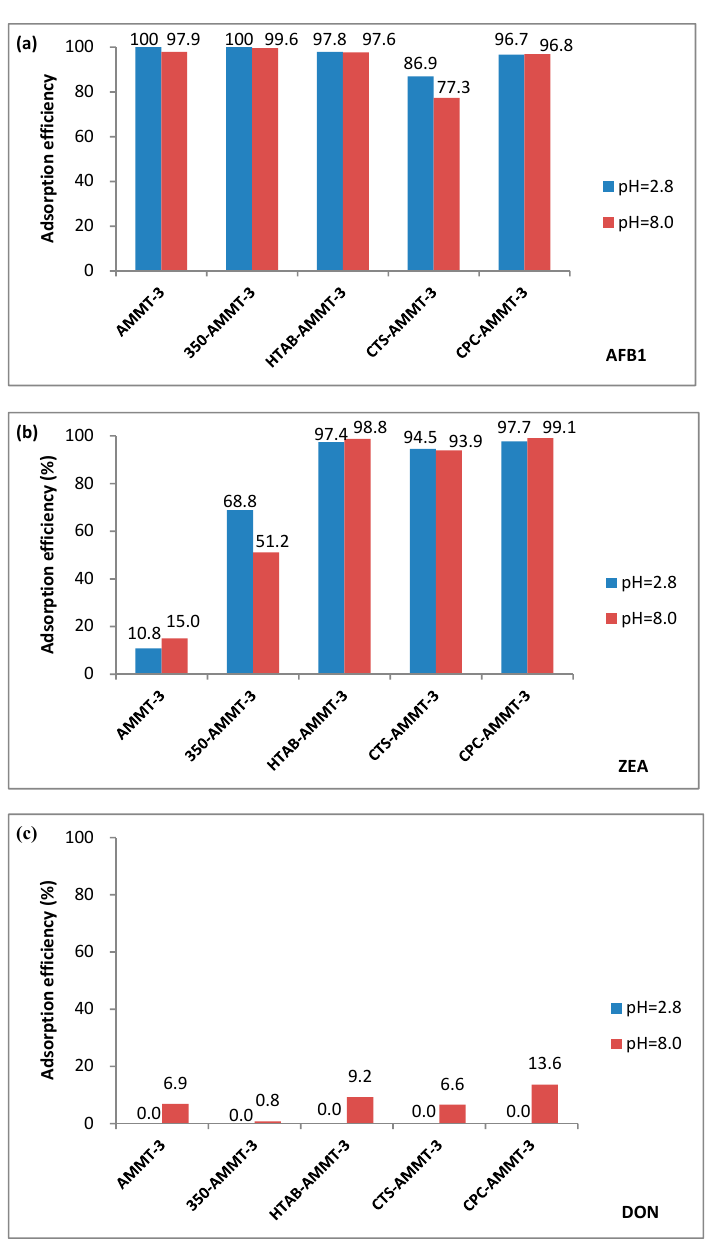
Figure 4. Adsorption efficiency of AFB1 ( a ), ZEA ( b ) and DON ( c ) over the modified montmorillonites. Comparing the adsorption efficiency of ZEA over AMMT-3 and 350-AMMT-3, the former is only 10.8% and 15.0%, while the latter is 68.8% and 51.2% under acid and alkaline conditions, respectively. The result indicates that the hydration-shell water exhibiting before thermal modification prevents the adsorption of ZEA. As for organic-modified AMMT-3, the adsorption efficiency for ZEA is over 90% whether under acid or alkaline conditions, far higher than those of AMMT-3. However, Wang et al.’s research indicated that the montmorillonites modified by surfactant only showed super-enhanced adsorption rates towards ZEA under acidic conditions but poor performance under alkaline conditions [24]. As discussed above, the increase in basal spacing and the improvement of hydrophobicity could enhance the adsorbability of ZEA over montmorillonite (illustrated in Figure 5). Thus, the organic modification on the surface of AMMT-3 activated by inorganic acids is the most efficient among the modified